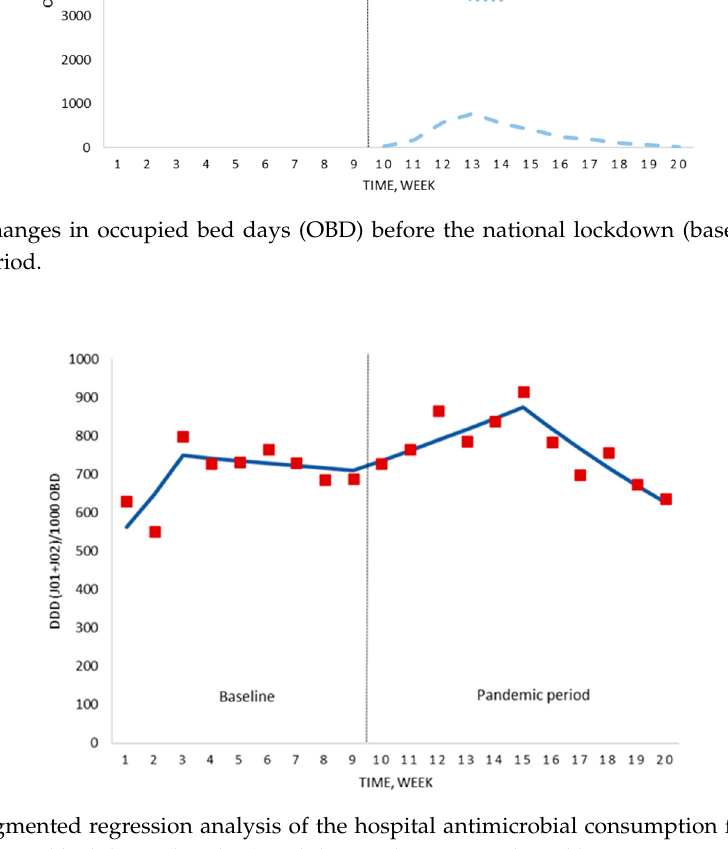
Figure 1. Changes in occupied bed days (OBD) before the national lockdown (baseline) and the pandemic period.